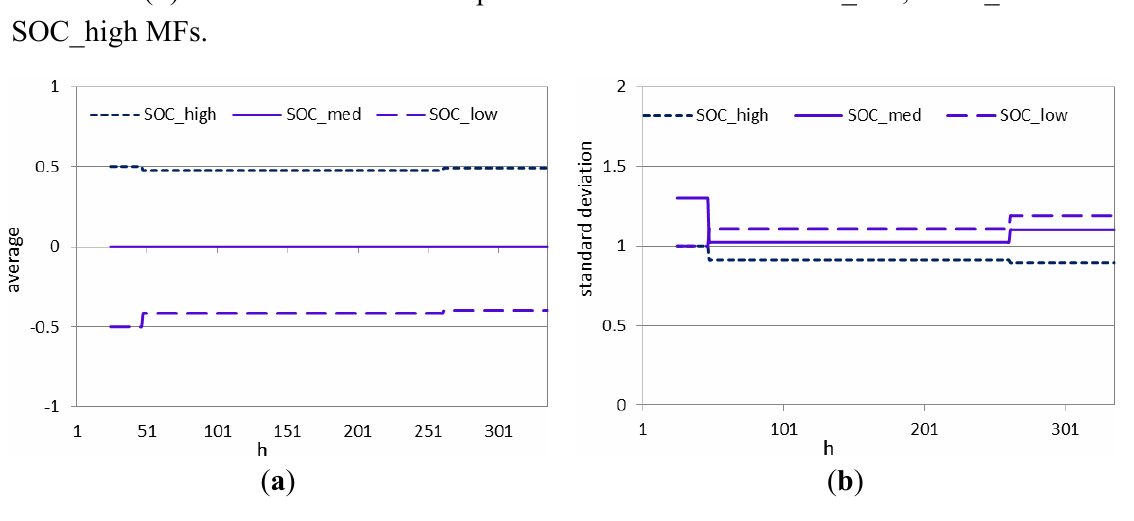
Figure 19. ( a ) Average parameters μ courses for Price_low, Price_med and Price_high MFs and ( b ) standard deviation σ parameters courses for Price_low, Price_med and Price_high